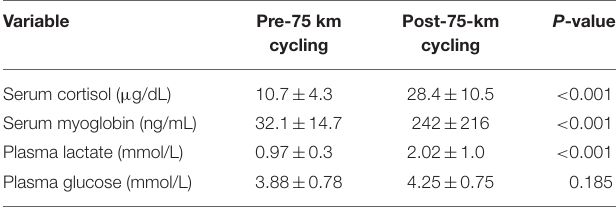
FIGURE 1 | Pre- and post-75-km cycling skeletal muscle glycogen levels in N = 20